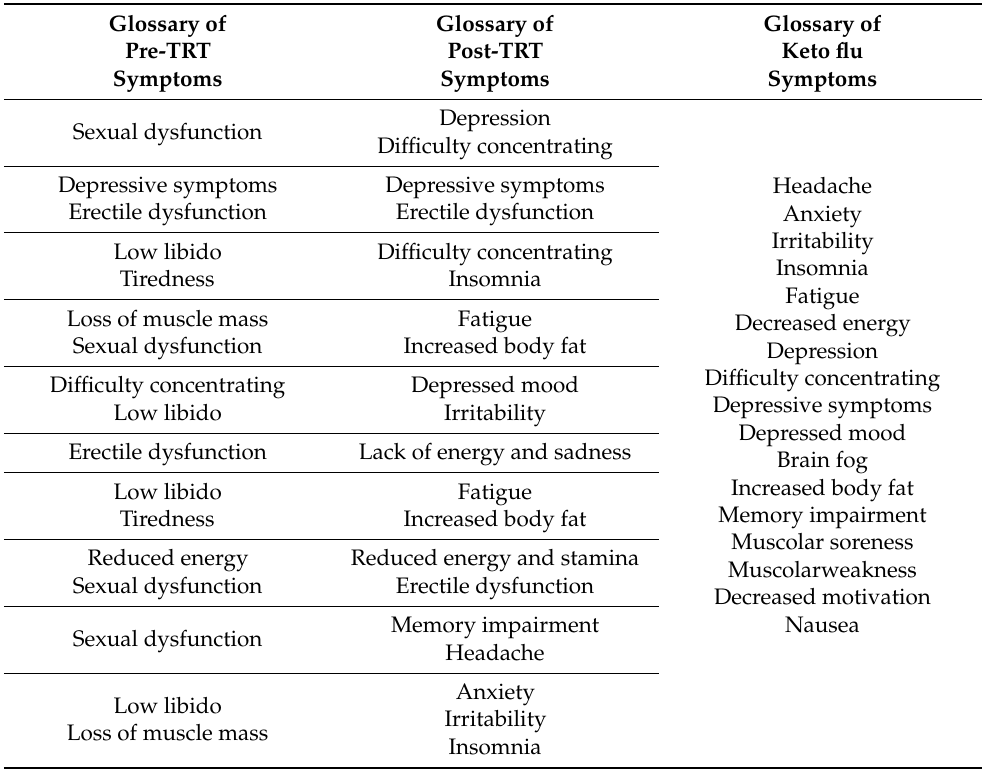
Table 2. Glossary of symptoms recorded before (A) and after (B) testosterone